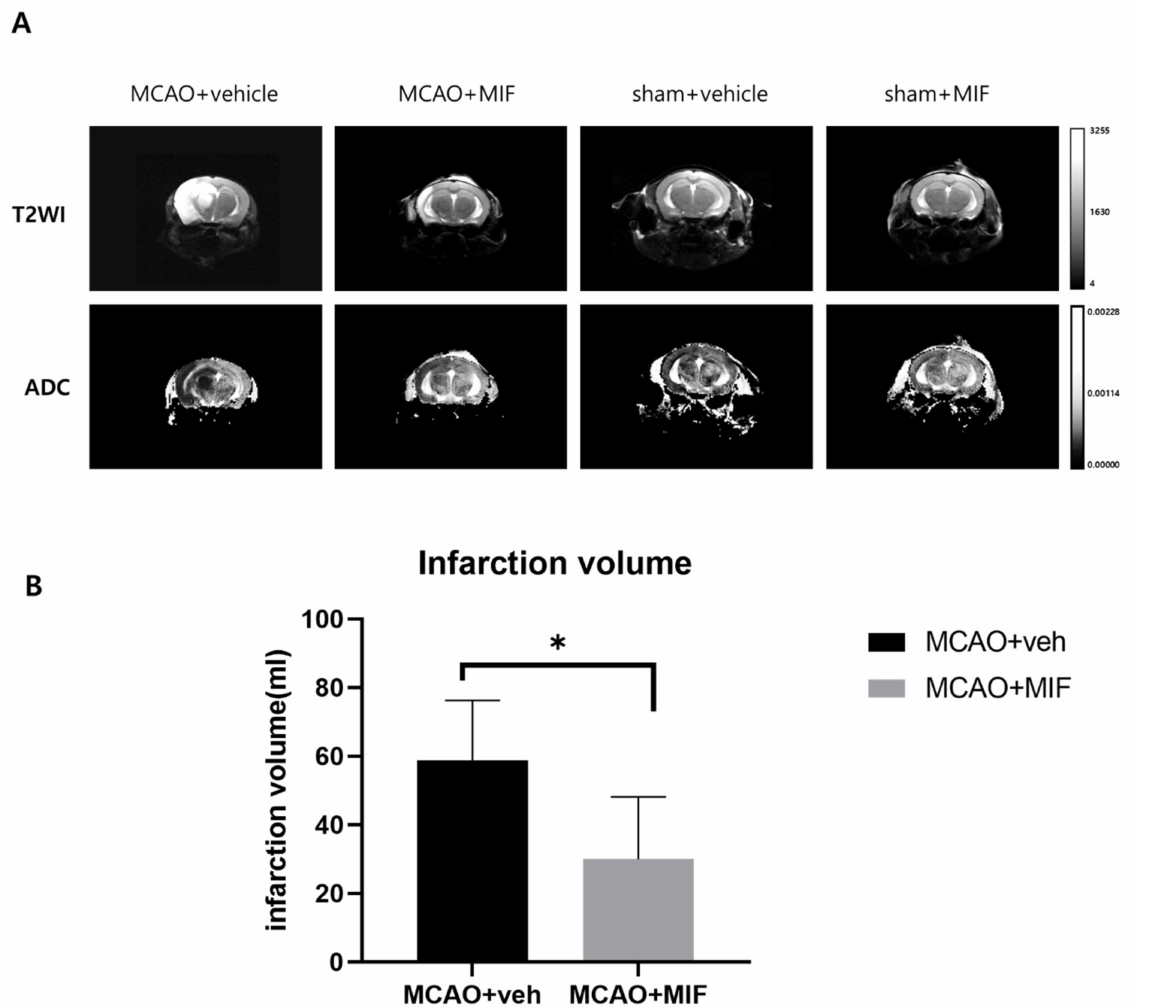
Figure 3. Infarction volume changes: ( A ) shows that representative images show the actual size of the infarct through T2WI, ADC; ( B ) shows that the infarction volume in the MCAO+MIF group ( n = 14) was significantly smaller than that in the MCAO+veh group ( n = 13), * p < 0.0001; the data were analyzed using a t -test to compare infarction size between two MCAO groups. Mean ± SD values are presented. MCAO: middle cerebral artery occlusion; MIF: macrophage migration inhibitory